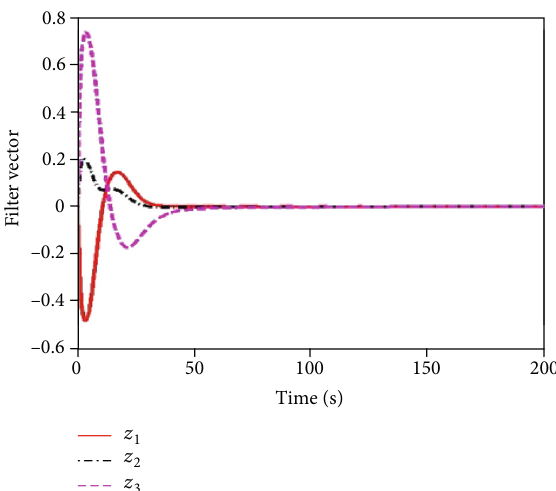
Figure 19: Time histories of angular velocities in Case 3 when k ð 0 Þ = 5 .